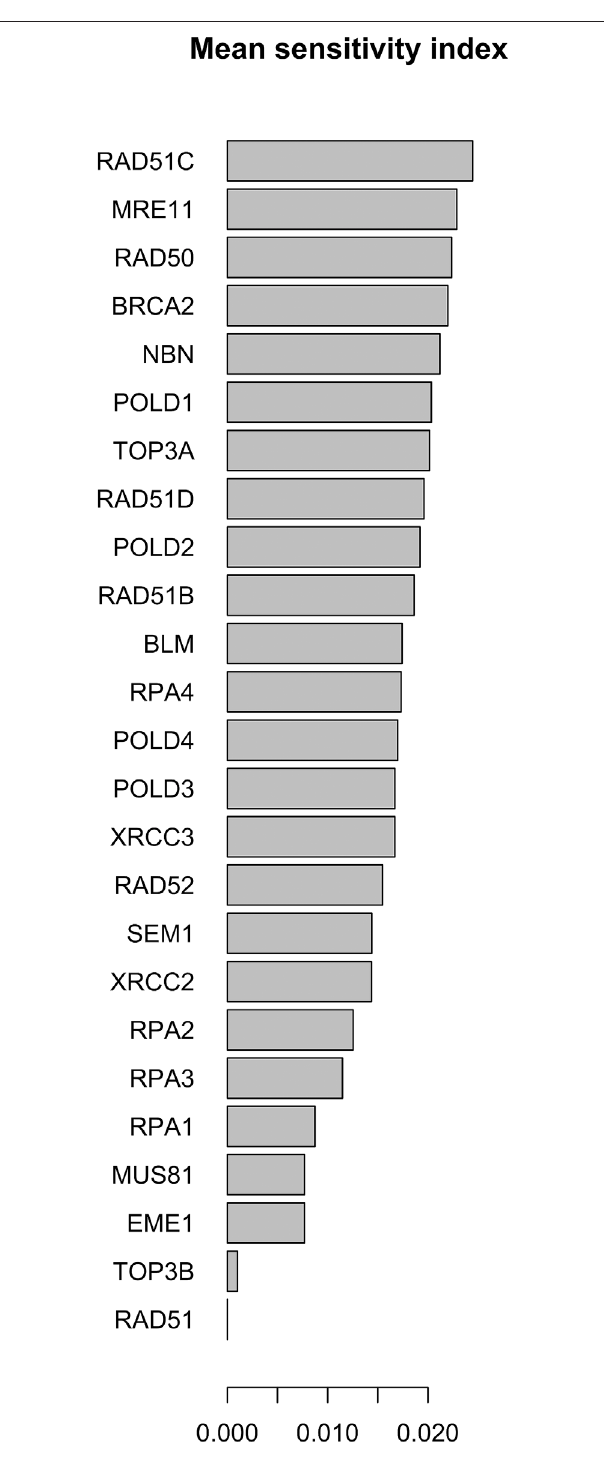
FIGURE 7 | Mean of the sensitivity index distributions for the proteins in HR network Orlic-Milacic, (2015). These results refer to simulation in the time interval[0,1400]a.u.,andinitialvaluesoftheproteinsrandomlysampledinthe range [18, 20] a. u. and kinetics rate values sample in [10 – 5 , 10 – 6 ] a. u.